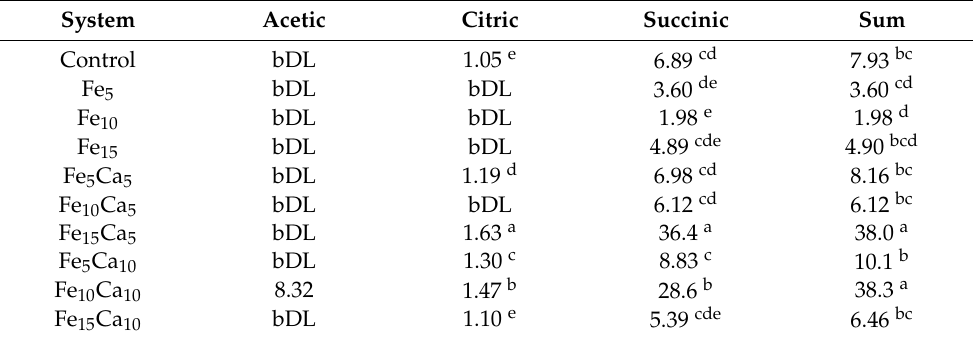
Table 2. Content ( µ g g − 1 DW) of low molecular weight organic